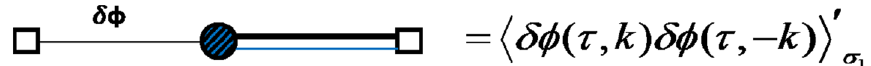
Fig. 5 In this diagram we present the leading order correction to the power spectrum from two-point function based on Eq. (13) for the massive field δσ